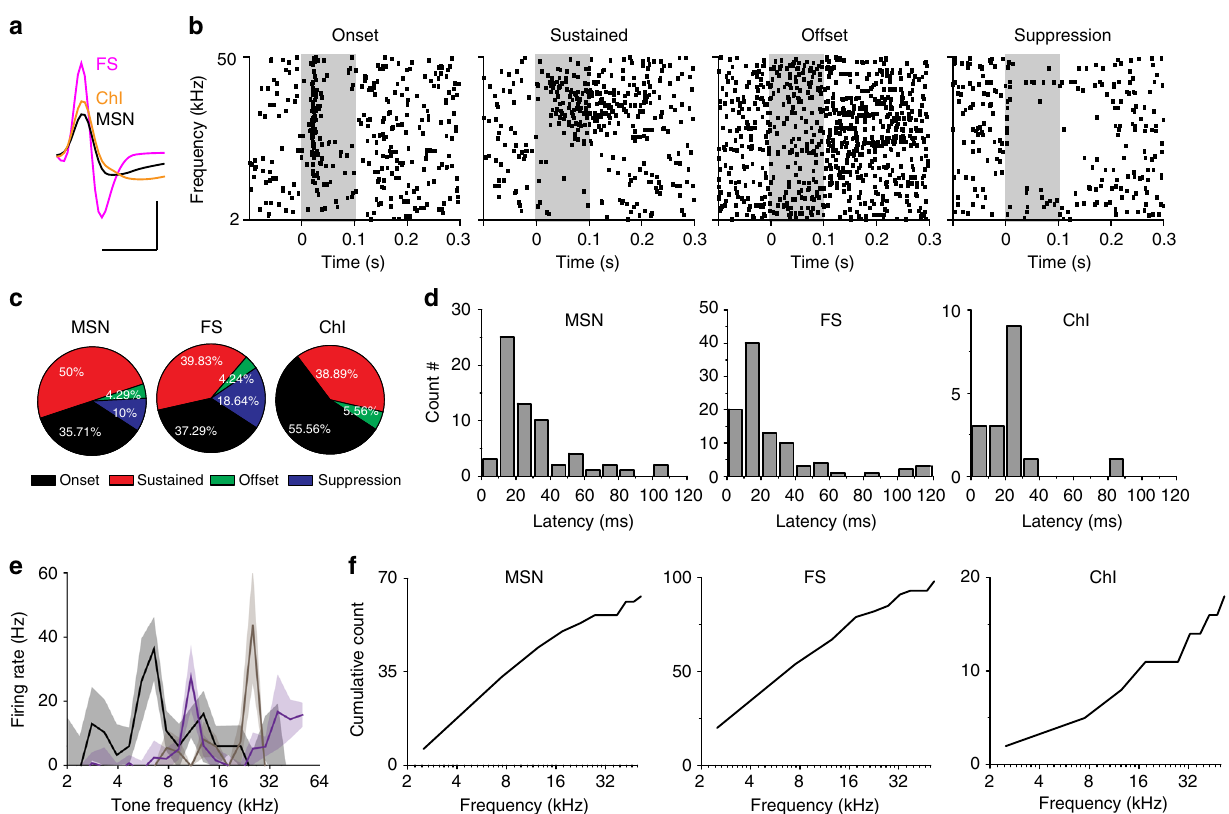
Fig. 2 Striatal neurons respond to tonal stimuli. a Example of isolated striatal single units for different cell types based on half-valley width of waveforms. Scale bars: 0.5ms and 50 µ V. b Example of striatal sound responses in raster plots. Individual pure tones ranged from 2 to 50kHz are presented at 0 – 0.1s time window (shaded area). c Portion of each type of tonal response for individual striatal cell types. d Distribution of response latency for individual striatal cell types. Latency was calculated as the time point when fi ring rate is signi fi cantly higher than the baseline (average fi ring rate of 0 – 50ms before the onset of tones). e Examples of three tuning plots. Averaged tone-evoked fi ring rates are plotted against the corresponding tone frequencies. Solid lines: mean values; shaded areas: standard errors. f Accumulative curves of best frequencies for individual striatal cell types. For c – f : MSN, n = 70; FS, n = 118; ChI, n = 18;